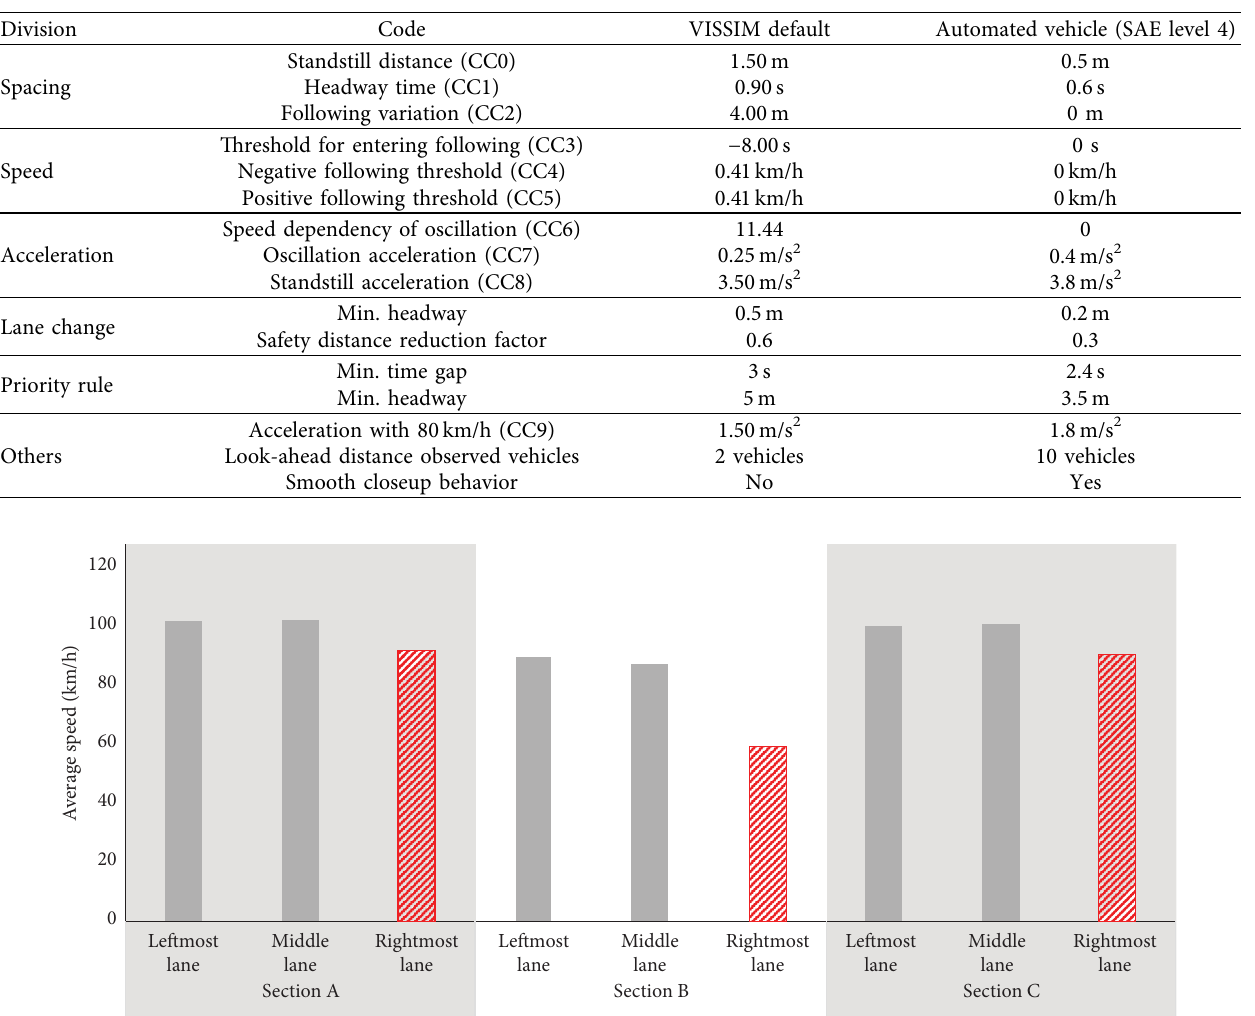
Table 3: Platooning implementation parameters